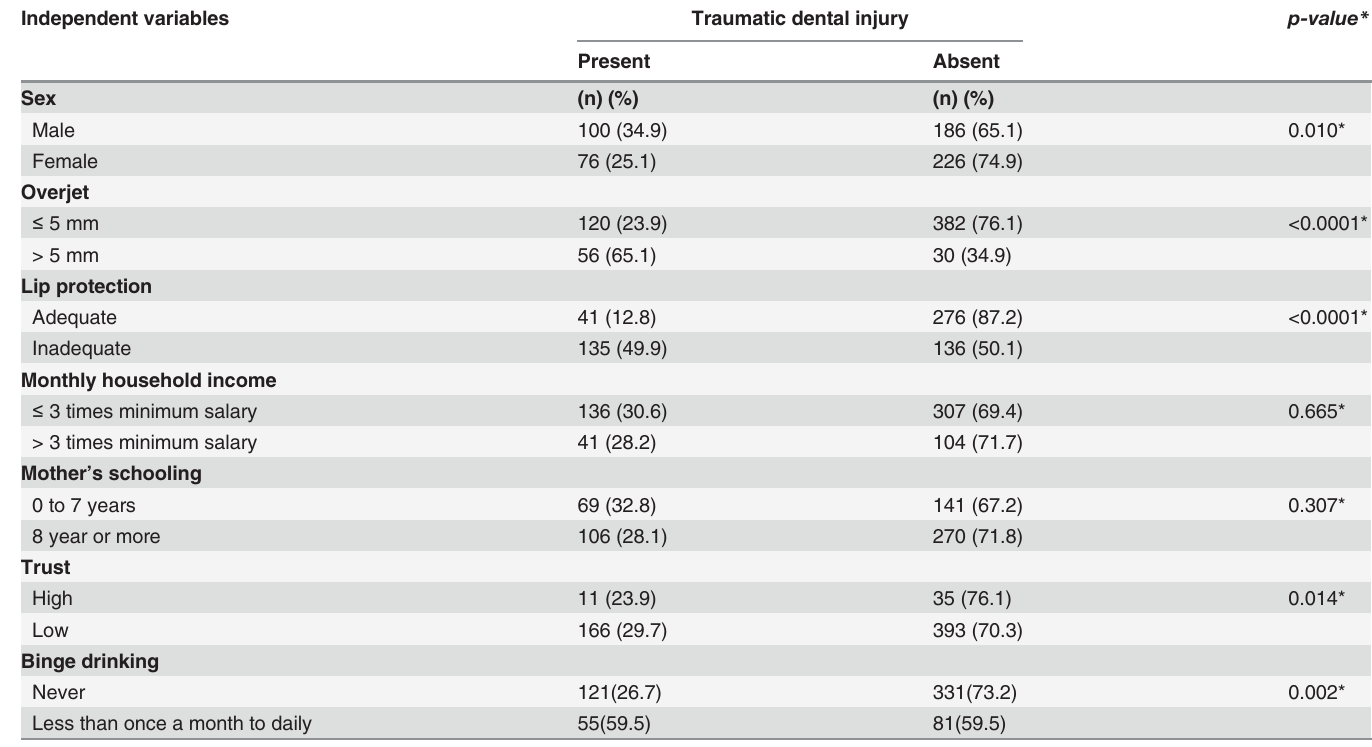
Table 1. Distribution of 588 12-year-old students according to traumatic dental injury and independent variables, Brazil, 2014. Independent variables